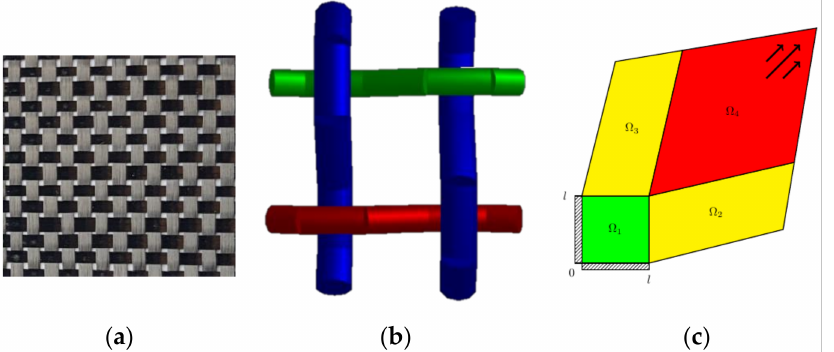
Figure 6. ( a ) Simple weave pattern; ( b ) periodicity cell parametrized by the distance between yarns, their thickness and contact between yarns; ( c ) schematic structure domain with fixation on a part of the lateral boundary.